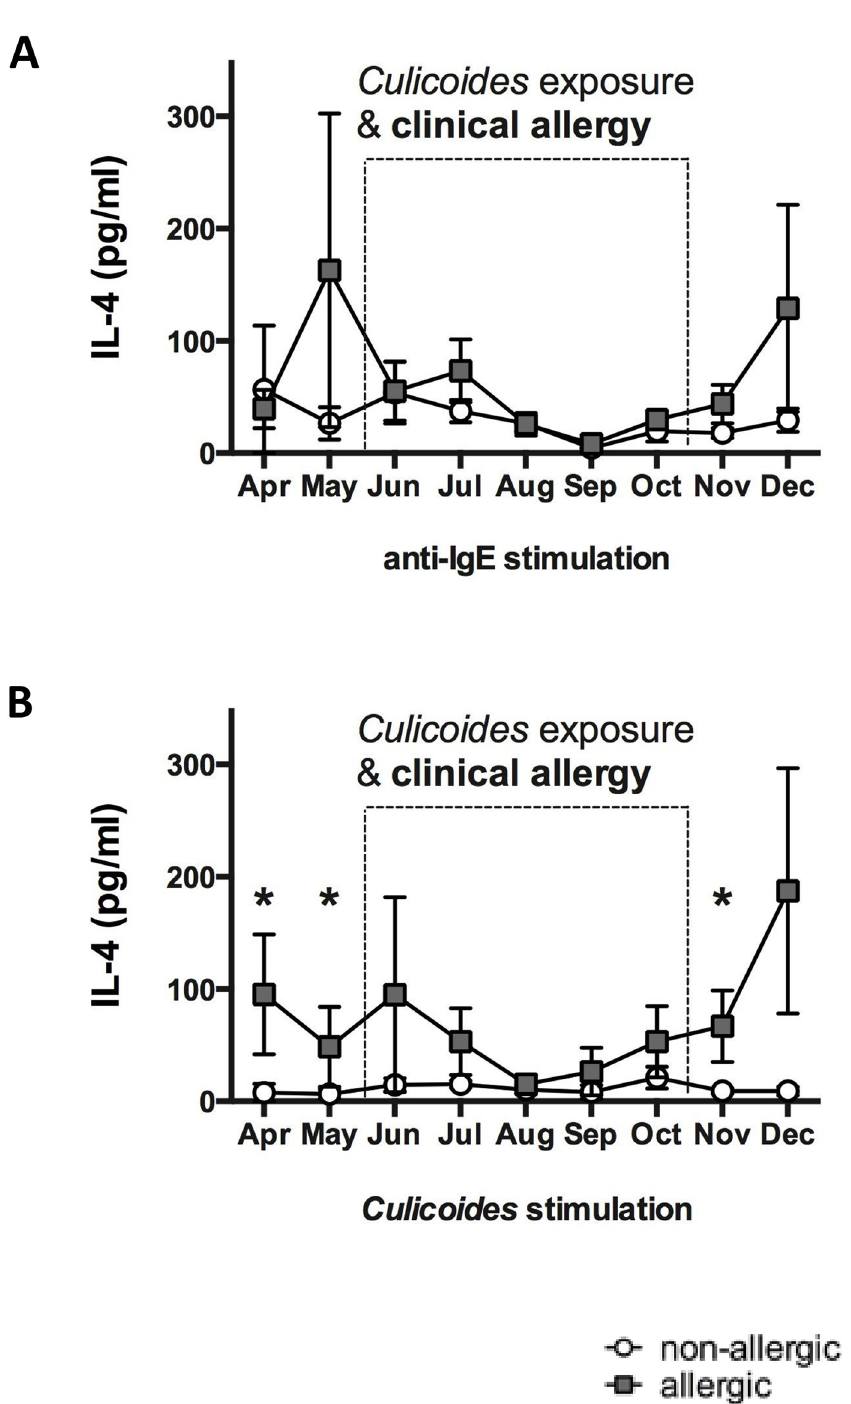
Fig 1. Anti-IgE and Culicoides (Cul) stimulation induced IL-4 secretion in PBMC of allergic and non-allergic horses. Blood samples were obtained monthly from allergic (n = 8) and non-allergic horses (n = 8) from April to December. The dotted box indicates the period of environmental exposure to Cul when horses with CH showed clinical signs of allergy. PBMC were stimulated in vitro with different stimuli, cell culture supernatants were harvested after 24 hours of incubation, and IL-4 was measured in the supernatants using a fluorescent bead-based IL-4 assay. IL- 4 secretion from PBMC after stimulation with A) anti-IgE, clone 134, which crosslinks IgE on the cell surface, and B) Cul extract. Graphs represent means with standard errors. Allergic and non-allergic groups were compared using non- parametric Mann Whitney tests. � p < 0.05.